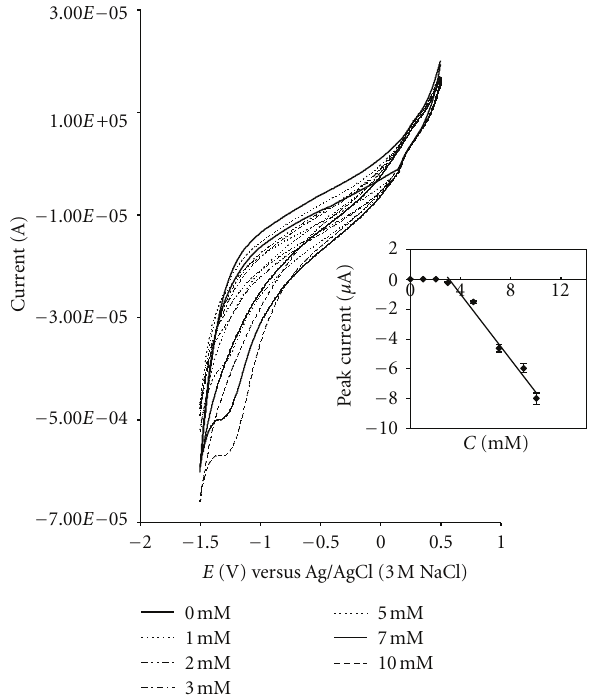
Figure 6: Reduction of H 2 O 2 on 20% (w/w) modified PB SCNRPE. v = 50mV/s, 0.1 M phosphate bu ff er (pH = 6.9).